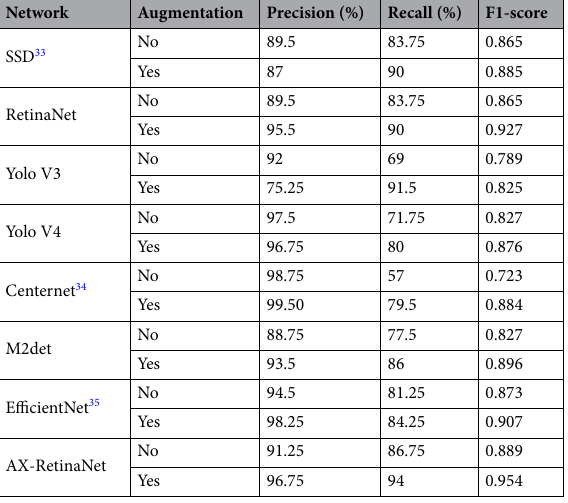
Table 1. Precision, Recall, and F1-score values of the detection and identification results of different networks.